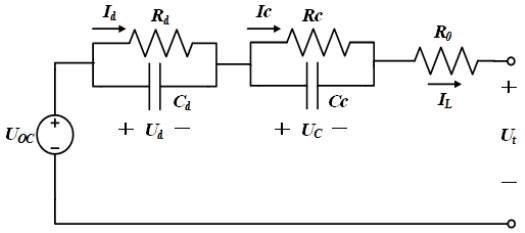
Figure 1. Equivalent circuit model (ECM).